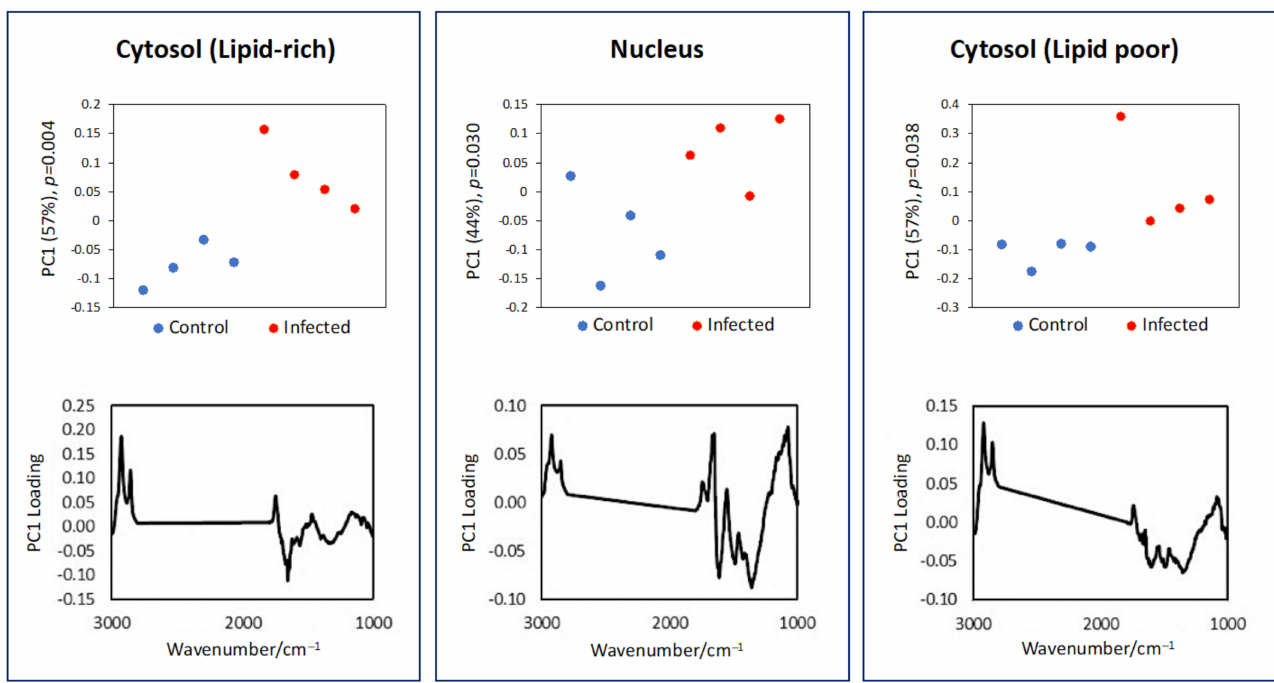
Figure 5. Pairwised (control versus infected) PCA1 of the extracted spectra (shown in Figure S6) from the three subcellular regions (cytosol (lipid-rich), nucleus, and cytosol (lipid poor)) with the most distinct differences between infected and uninfected cells at 48